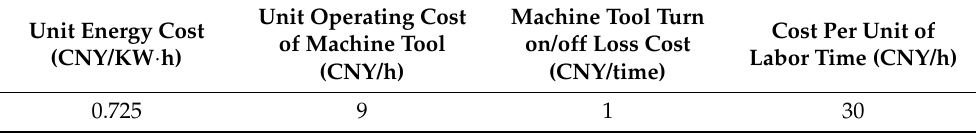
Table 7. Related unit